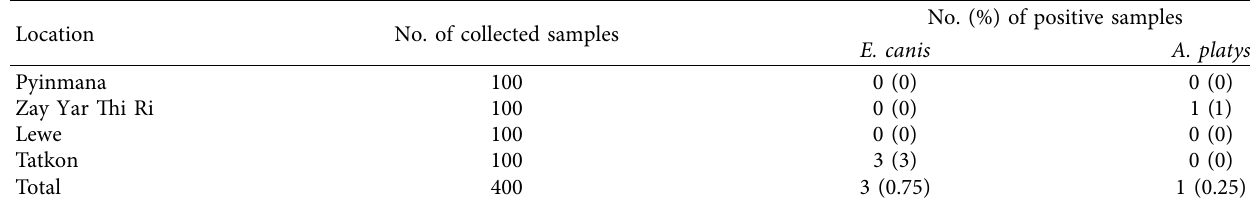
Table 1: Prevalence of E. canis and A. platys in four townships within Nay Pyi Taw area.